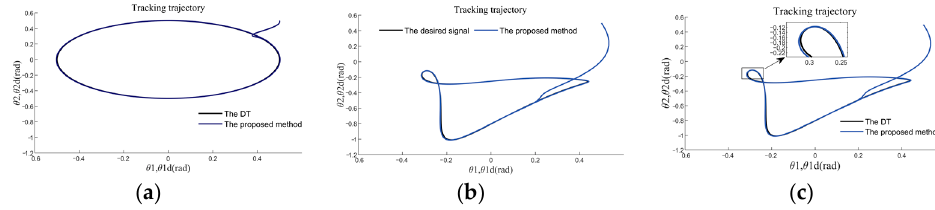
Figure 15. 2-D trajectory tracking of the hip and knee joints. ( a ) 2-D trajectory tracking of the hip and knee under case 0; ( b ) 2-D trajectory tracking under case 1; ( c ) 2-D trajectory tracking under case 2.